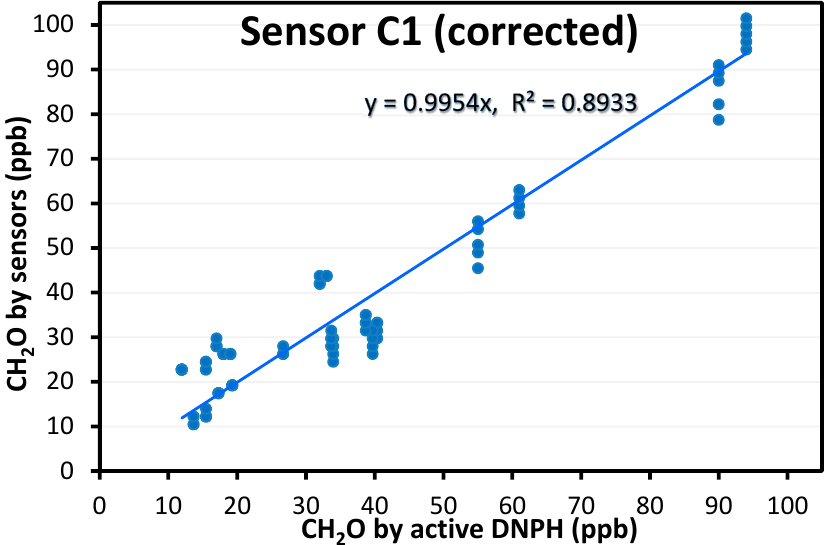
Figure 5. HCHO concentration (ppb) scattered experimental points and regression line versus reference method (DNPH) for Sensor C1.